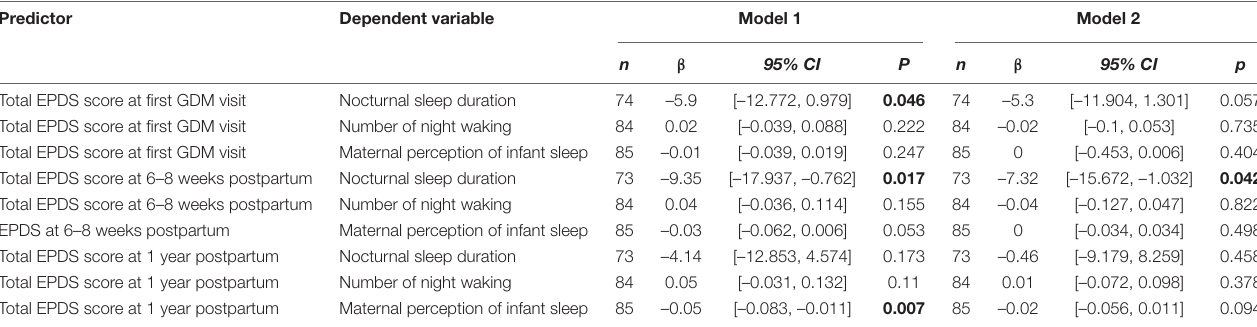
TABLE 2 | Associations between maternal depressive symptoms at first GDM visit, 6–8 weeks postpartum and 1 year postpartum with infant sleep characteristics at 1 year postpartum before (model 1) and after adjustments (model 2). Predictor